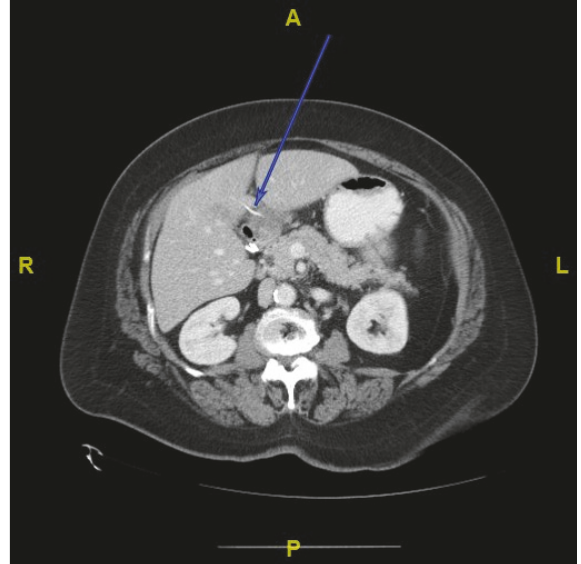
Figure 4: 7-week follow-up imaging shows interval improvement of hepatic abscess without any migration of foreign